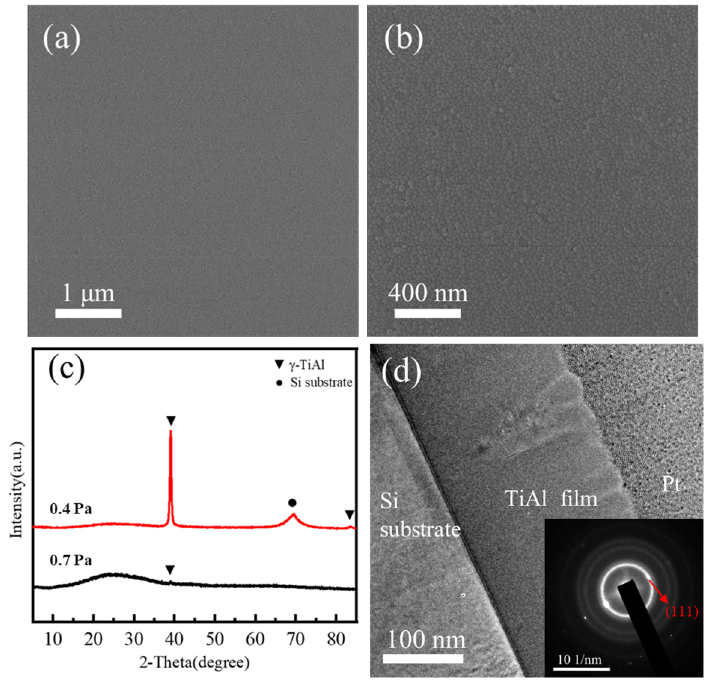
Figure 1. ( a , b ) HIM surface images of TiAl film grown at 0.7 Pa; ( c ) XRD patterns of TiAl films produced at different Ar pressures (0.4 and 0.7 Pa); and ( d ) bright-field cross-sectional TEM images of TiAl film prepared at 0.7 Pa. The inset image is the corresponding SAED.